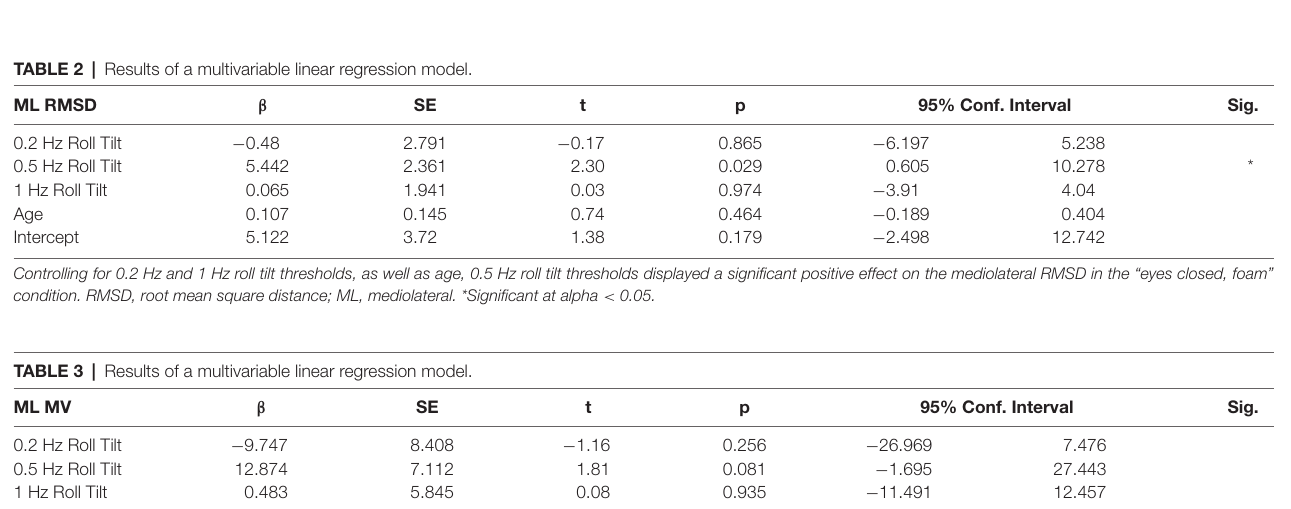
FIGURE 4 | Relationship between 0.2 Hz roll tilt thresholds and RMSD, mean velocity, and mean frequency for both the mediolateral plane (top) and anteroposterior plane (bottom) during an “eyes closed, foam” balance task. To the right of the plots, the task and relevant balance control systems are displayed, showing a dominance of vestibular cues in the “eyes closed, foam” condition. Each data point represents one individual’s performance. The blue line shows a linear fit with the 95% CI depicted by the gray shaded region. No statistically significant relationships were seen between 0.2 Hz thresholds and postural sway. RMSD, root mean square distance.